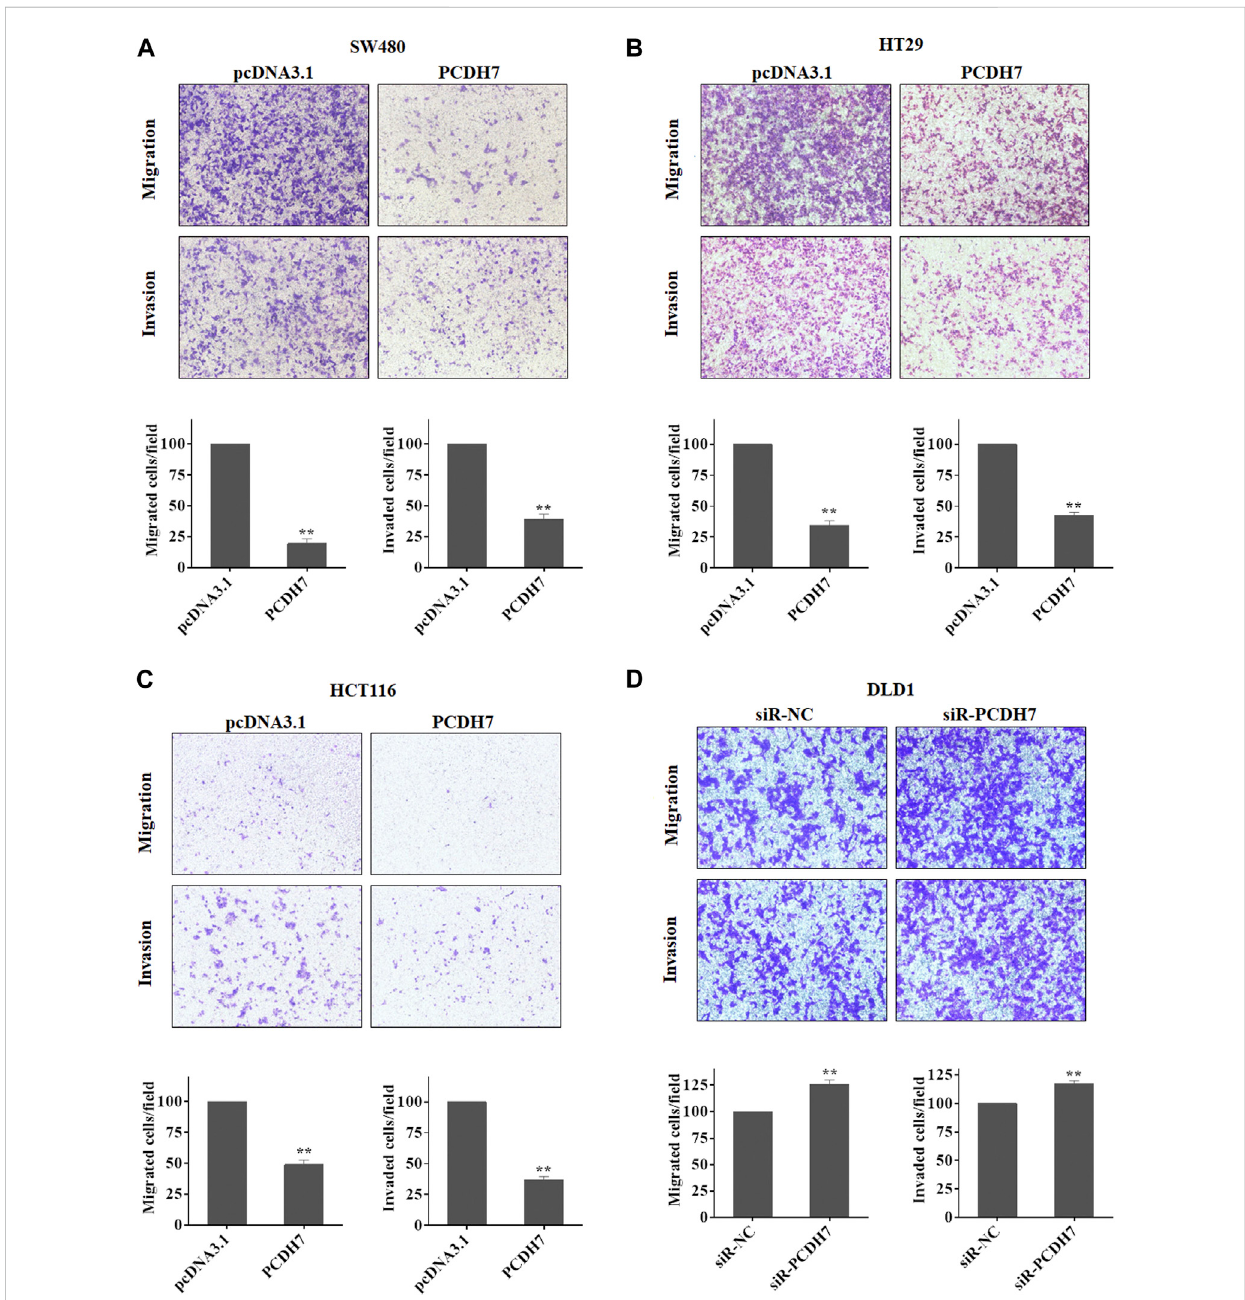
Roles of PCDH7 in CRC cell migration and invasion. (A – C) Transwell assays were used to determine the potentials of cell migration and invasion in SW480, HT29, and HCT116 cells with PCDH7 overexpression. (D) Transwell assays were performed to detect cell migration and invasion in DLD1 cells with PCDH7 knockdown. Data are presented as mean ± SD for three separate experiments. ** p < 0.01 vs.